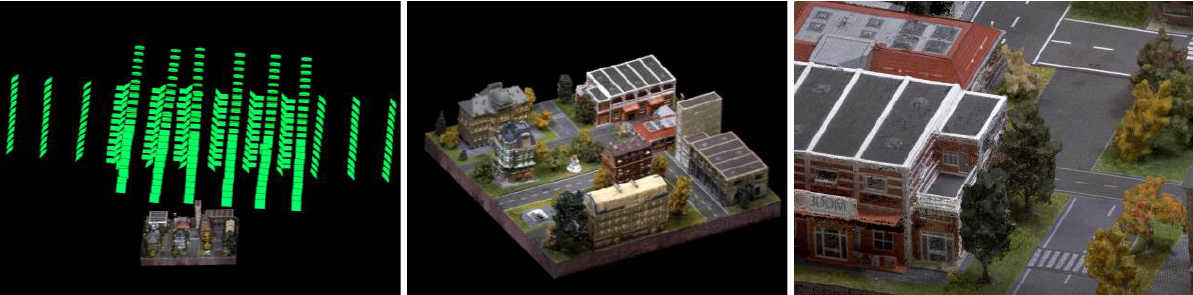
Figure 3. Examples of the datasets available within the “ 3DOMcity” photogrammetric contest: reference image network (left), reference DIM point cloud (overview in center and close-up view on the